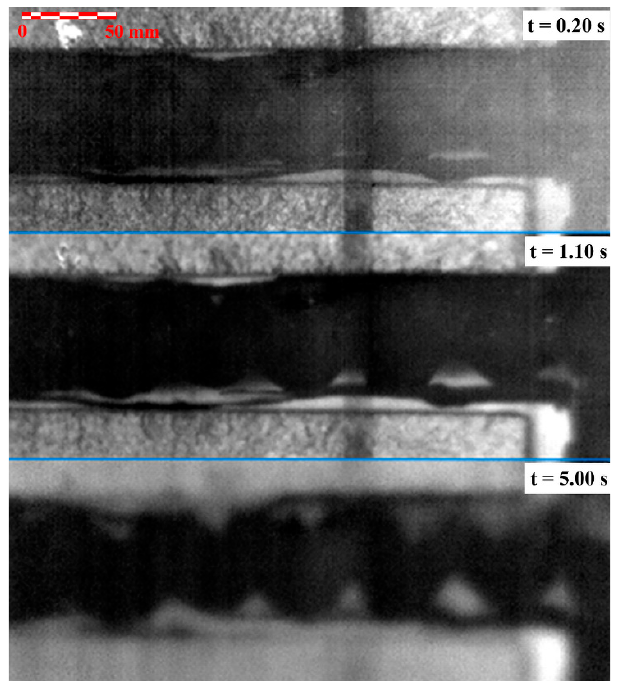
Figure 7. Sequence of the thermograms of the bonded